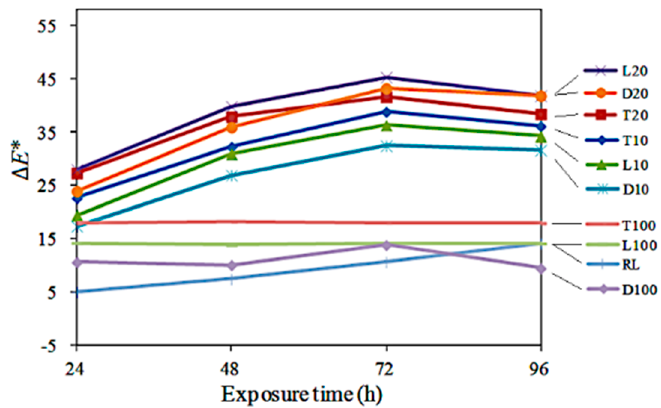
Figure 4. Time-dependent color difference ( ∆ E *) of OMRL films under UV light irradiation.